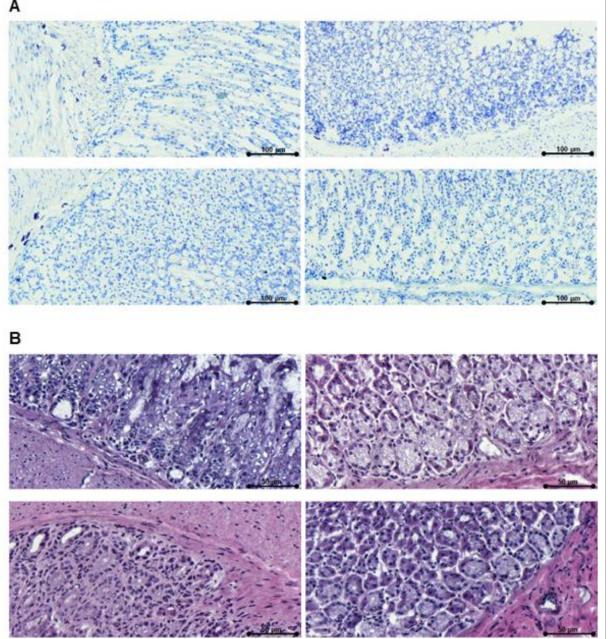
Figure 7. Murine gastric antrum tissues. Panel ( A ) shows mast cells in the gastric mucosa after staining with toluidine (bar size, 100 µ m). Panel ( B ) depicts eosinophils after hematoxylin and eosin staining (bar size, 50 µ m). In both panels, the figure on the upper left side shows representative staining from group A, and the figure on the upper right side—staining from group B. Lower left side and lower right side show stainings from group D and the naïve group,